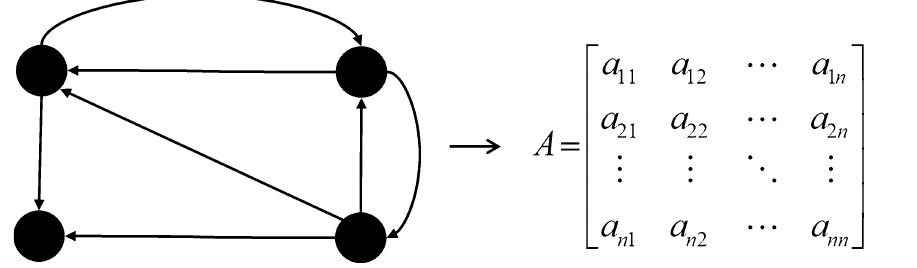
Figure 1. An FACS graph and its adjacency